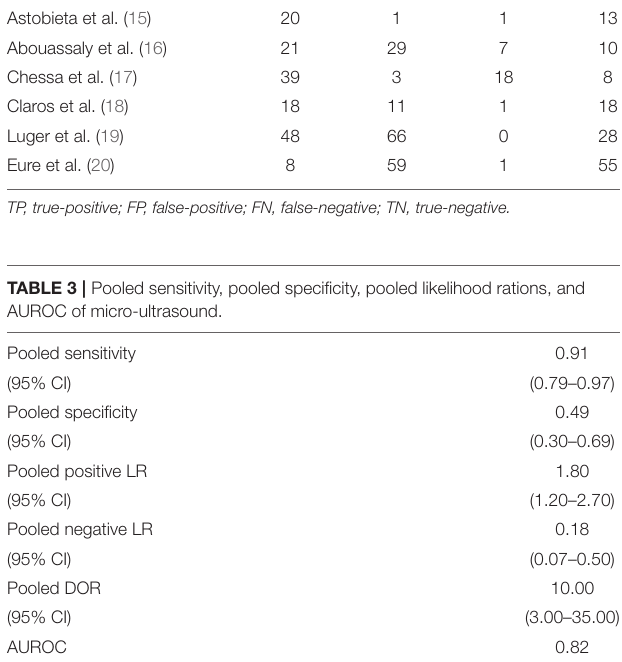
almost symmetrical, suggesting low publication bias ( P = 0.41; Figure 6